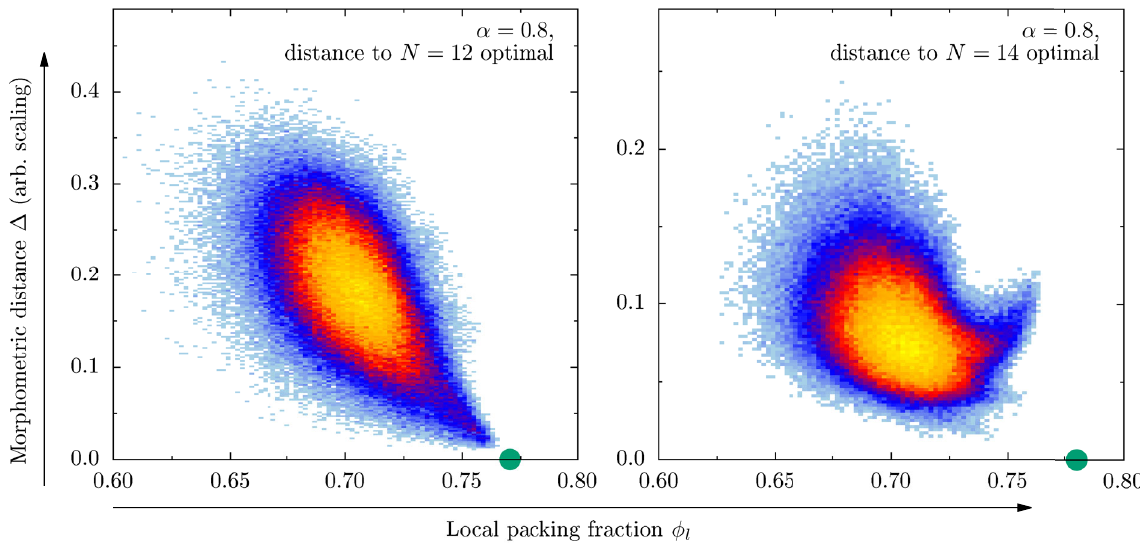
ð ref Þ . Figure 8 with the MSM for the reference structure, q l shows the distribution of the morphometric distances Δ and local packing fractions ϕ in random packings of α ¼ 0 . 8 l ellipsoids (other aspect ratios show the same result). On the left, the reference structure is the 3-3-3-3 structure for α ¼ 0 . 8 . A continuum of local structures approaches the reference motif (green bullet on the horizontal axis). On the right-hand side, the reference structure is the optimal 1-6-6-1 motif. The particles show no propensity to form this structure in a random packing.